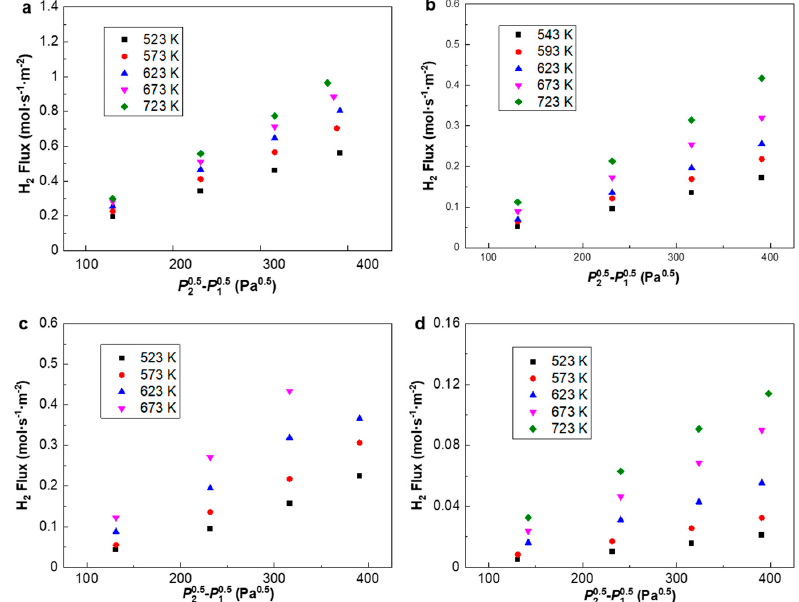
Figure 7. Hydrogen flux profile of ( a ) PA-1, ( b ) PA-2, ( c ) PAP-1 and ( d ) PAP-2 plotted against P 2 - P 1 at 523 K–723 K. P 2 and P 1 indicate the feed and permeate pressures, respectively.